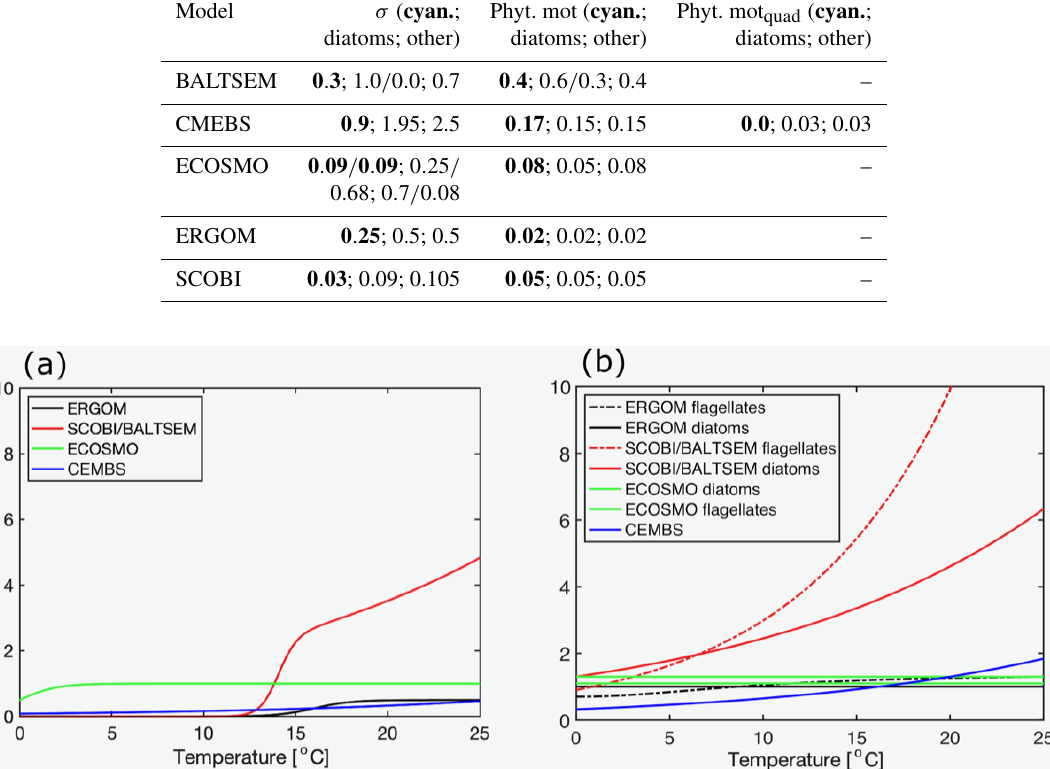
Figure 1. (a) Temperature dependence of the maximum growth for (a) cyanobacteria and for (b) other functional groups in the five considered biogeochemical models (d − 1